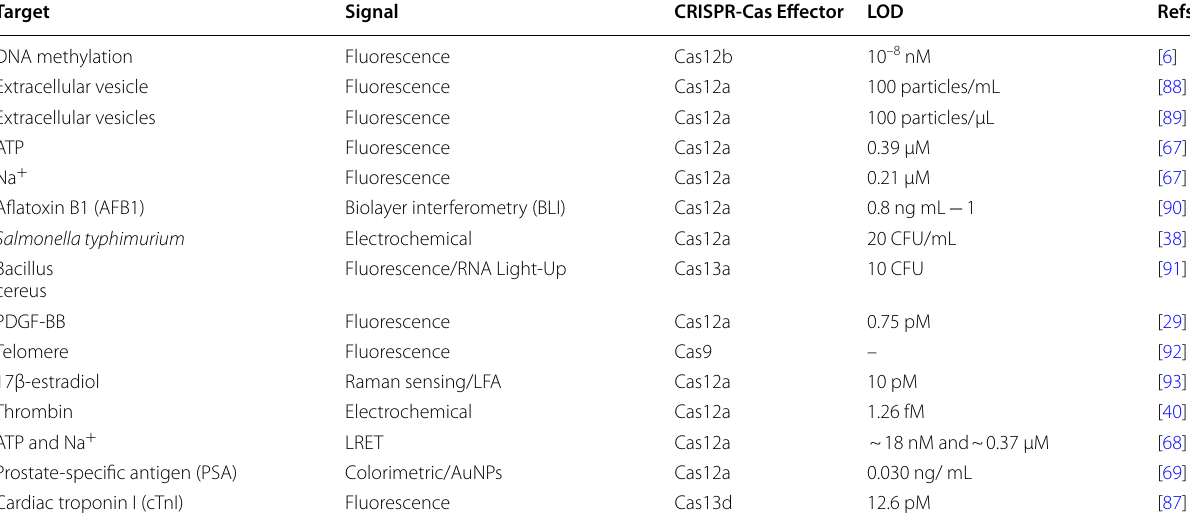
Table 2 Key representative examples of CRISPR-Cas proteins and aptamers in diagnostic assays of variety of targets